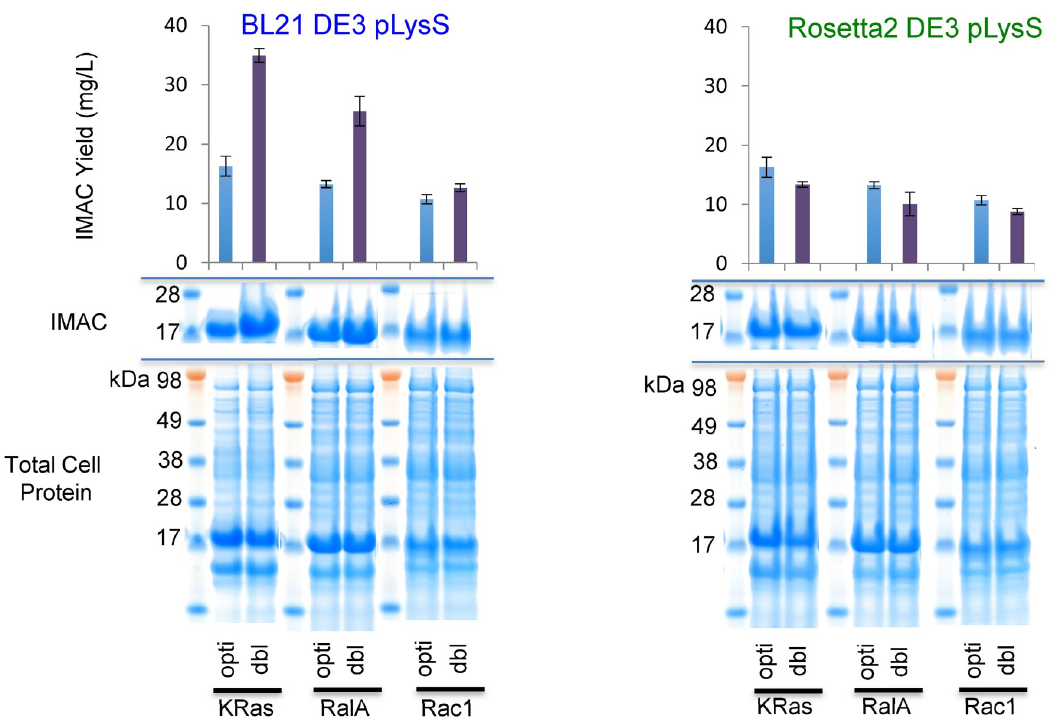
Fig 6. The benefit of non-optimal codons is lost on supplementation with rare tRNAs. The improvements observed on the introduction of two rare codons (dbl) into each optimized reading frame is dependent on the relative lack of the corresponding tRNA. Whilst the uplift is sustained in a BL21 DE3 pLysS strain, the benefit of rare codons is lost in Rosetta2 DE3 pLysS where the minority tRNAs corresponding to modifications are supplemented from an accessory